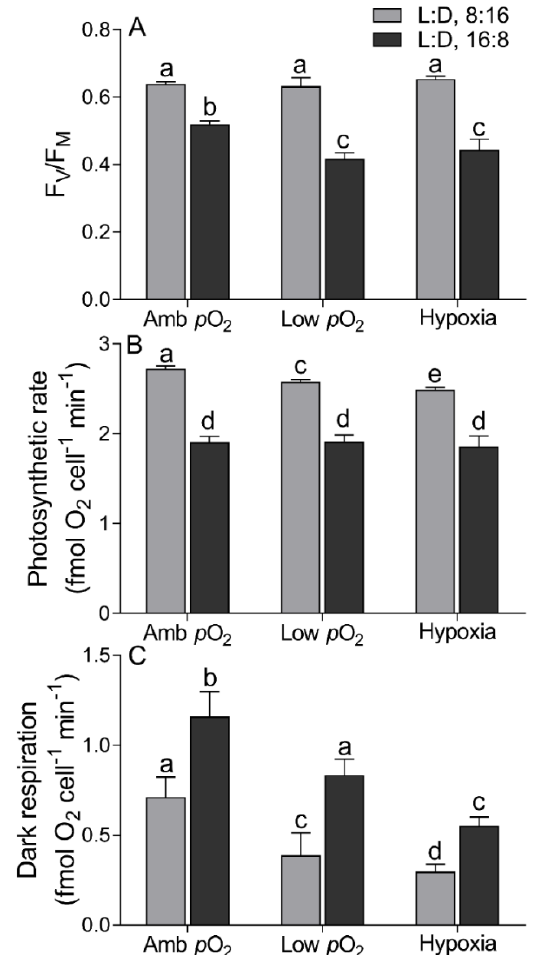
p O 2 treatments.